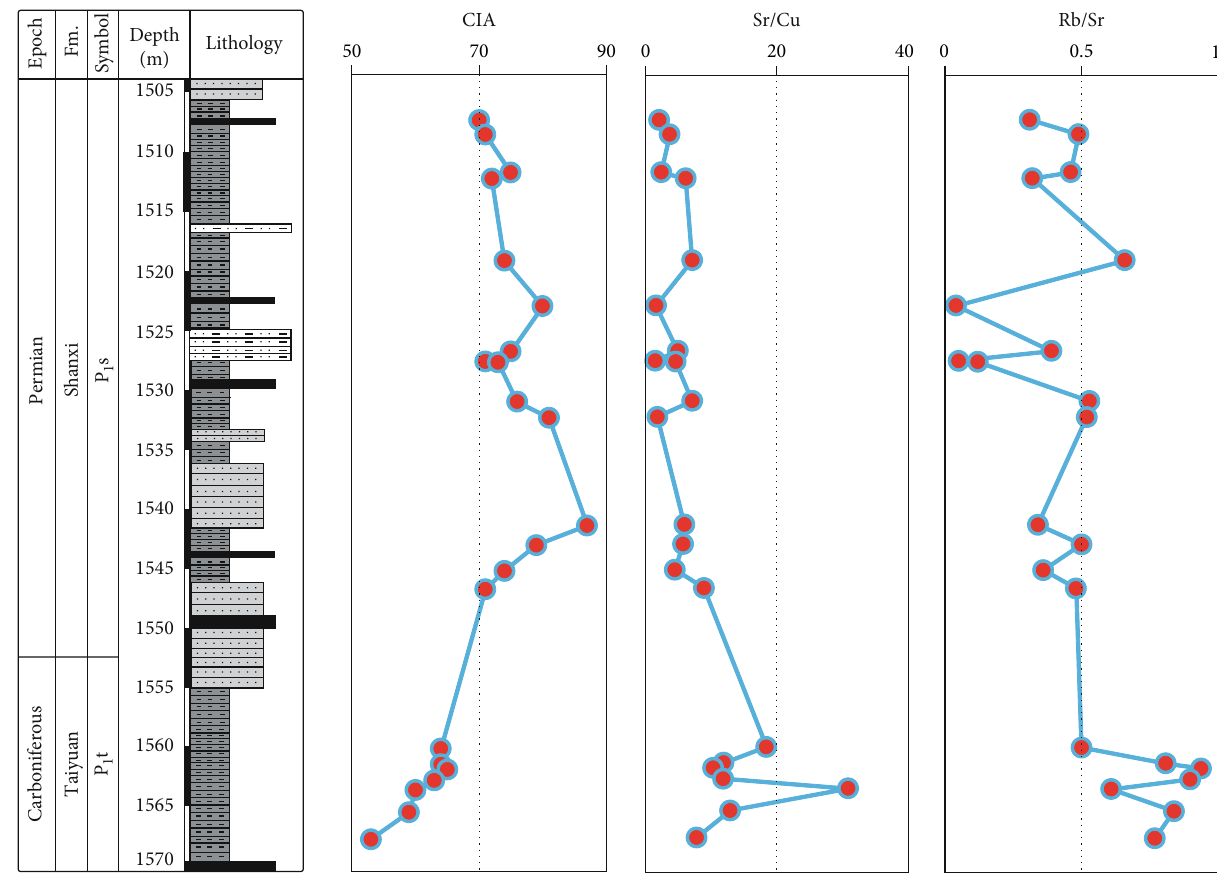
Figure 2: The stratigraphic distribution of paleoclimate proxies of the studied